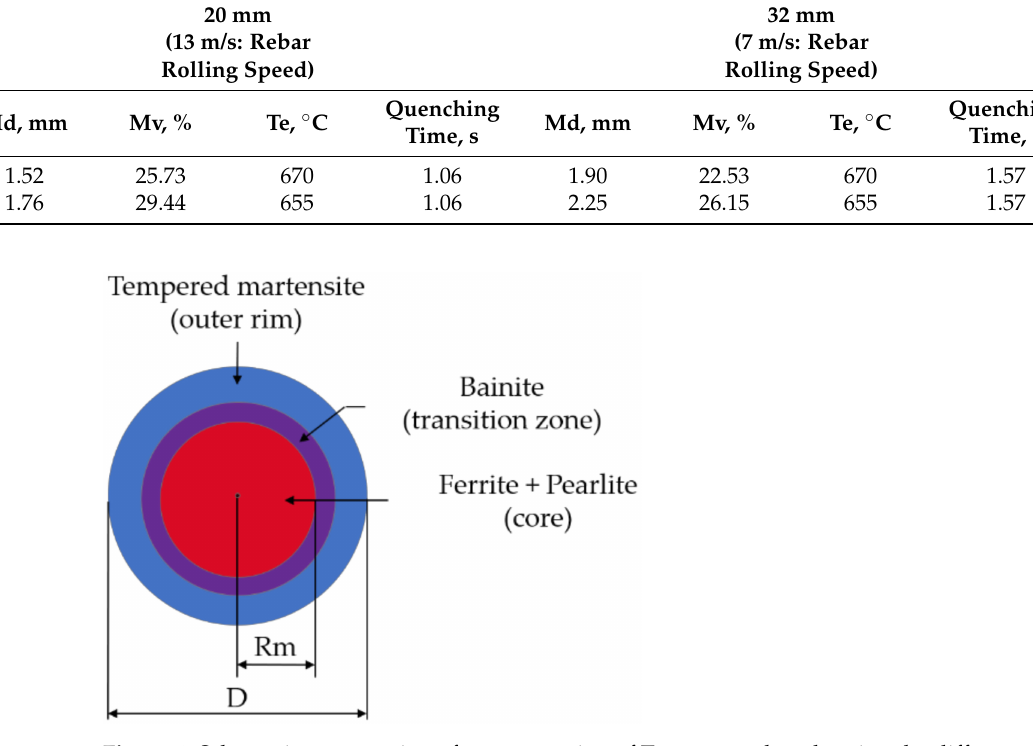
Figure 4. Schematic presentation of a cross-section of Tempcore rebar showing the different outer- surface rim and core zones with relative